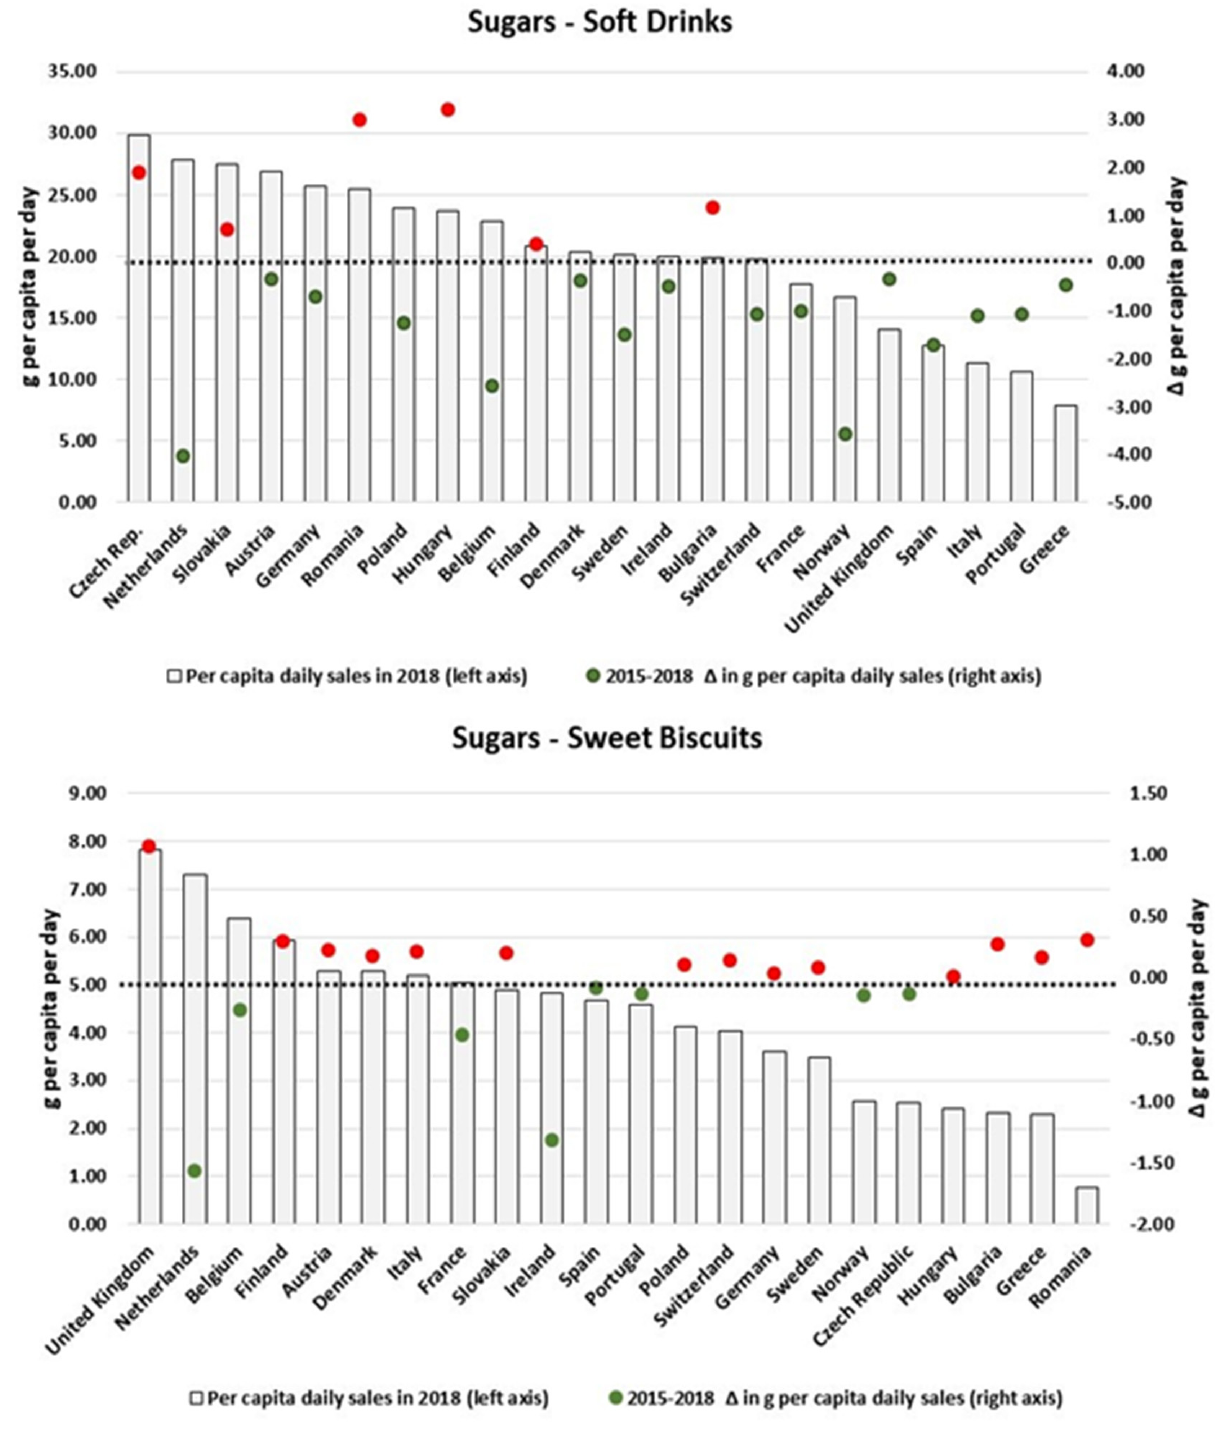
Figure 3. Estimates of total sugars sold through Soft Drinks and Sweet Biscuits in 2018 and the respective 2015–2018 variation (in g/pc/day). Source: Elaborated by the authors based on data from Euromonitor (2020) and mid-year population estimates from the HFA-DB. Estimates were scaled by market coverage to represent 100% of the retail market. The right-hand axis represents the nutrient variation in g per capita per day (green for negative values, red for positive values), and the dotted black line indicates the variation of 0 g per capita per day as a reference.